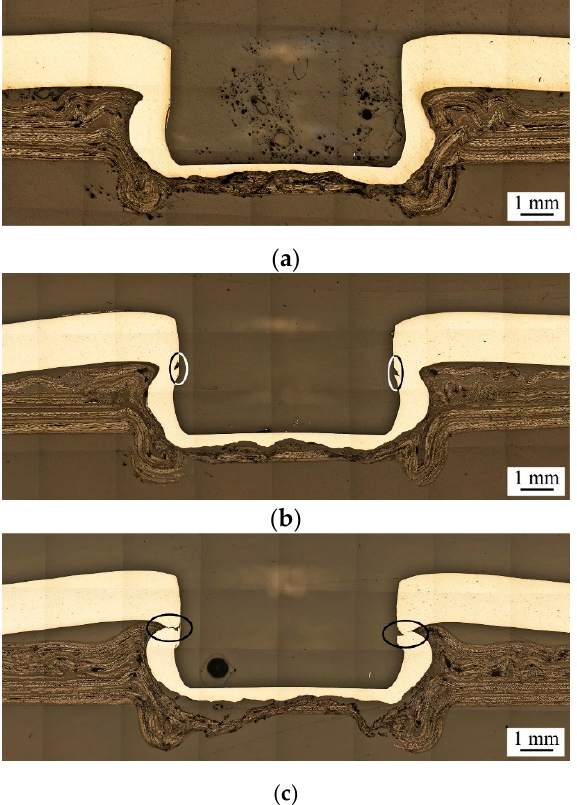
Figure 9. Cross-sectional micrographs of clinch joints under heating temperatures of ( a ) 97 °C, ( b ) 103 °C, and ( c ) 112 °C. The Punch P1, Die D1, punching force of 69 kN, and Heating Mode B are used.